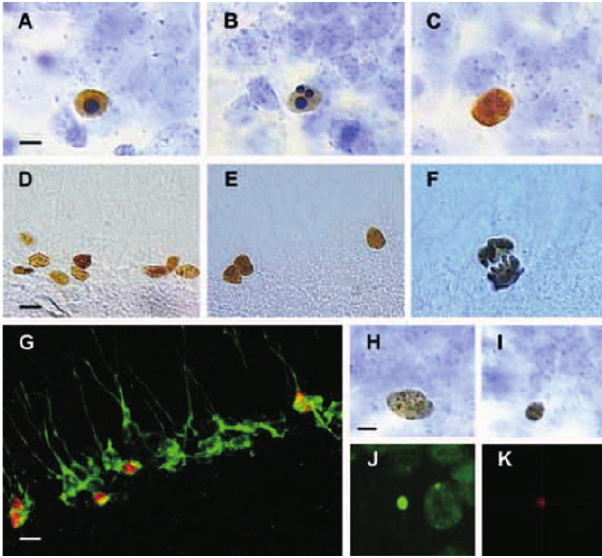
Figure 3. Representative Examples of Apoptotic, Newborn, and Proliferative Cells (A) Fractin-IR pyknotic cell. (B) Fractin-IR karyorrhexic cell. (C) Active-caspase-3-IR cell. (D) BrdU-IR cells. (E) Ki67-IR cells. (F) HH3-IR cell in anaphase. (G) BrdU-labeled cells (red) are stained with Dcx (green), a typical marker for immature newborn neurons. (H) Healthy BrdU-DAB-IR cell. (I) Pyknotic BrdU-DAB-IR cell. (J and K) Small BrdU-IR cell (red) exhibiting nuclear shrinkage using Fluoro Nissl Green counterstaining. Bar scales: (A–C), (F), and (H–K) indicate 5 l m; (D), (E), and (G) indicate 10 l